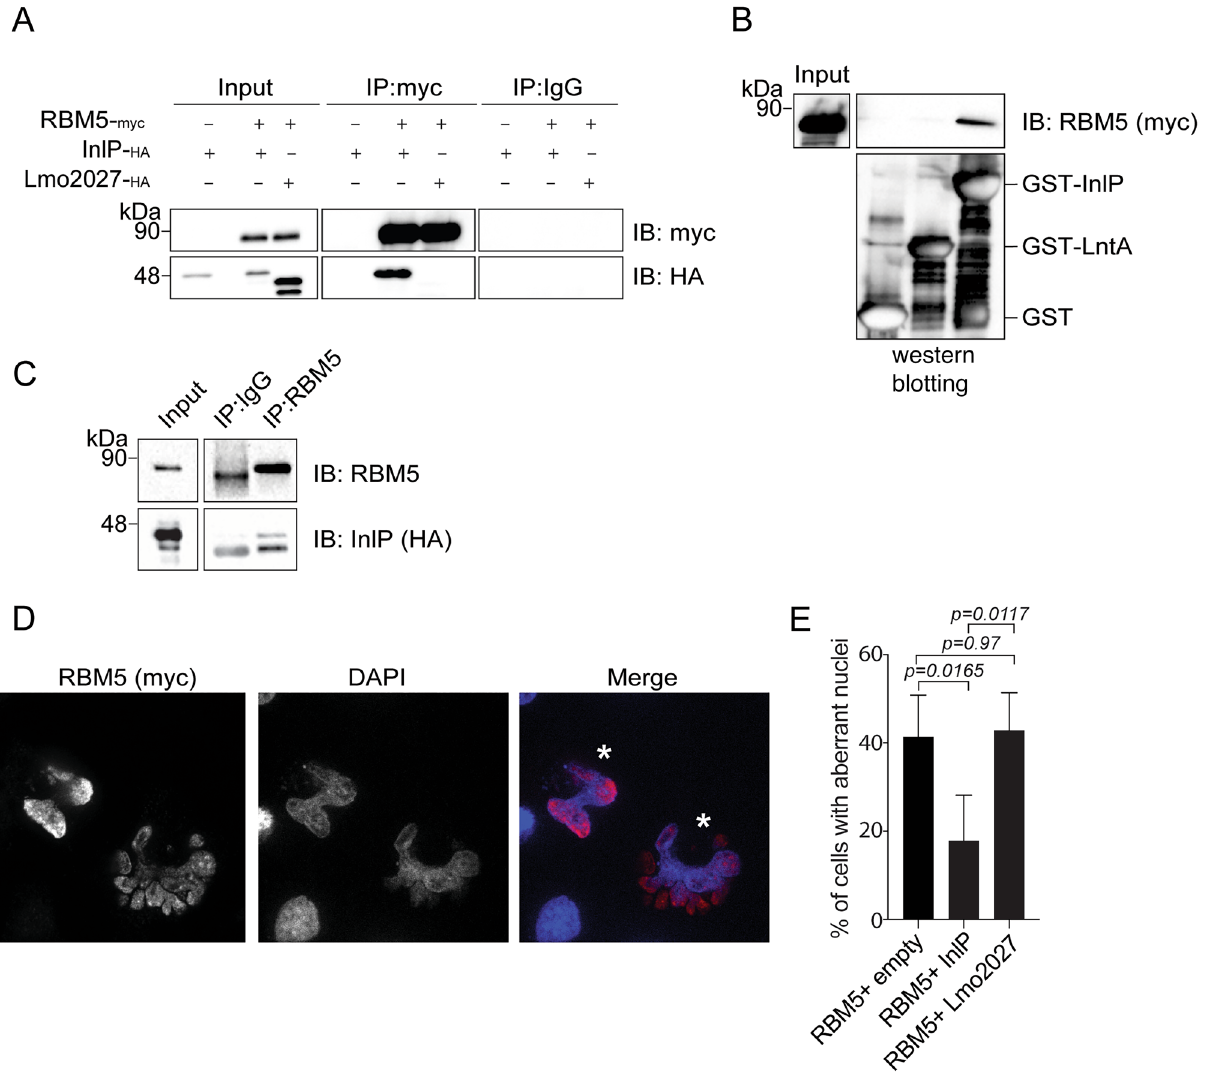
Figure 3. InlP targets RBM5. ( A ) Nuclear extracts from HEK293-FT cells co-expressing RBM5- Myc and InlP- HA or Lmo2027- HA were used in immunoprecipitations (IP) assays with Myc antibodies or IgG control and analyzed by immunoblots with Myc or HA antibodies. ( B ) Nuclear extracts from HEK293-FT cells transfected with RBM5- Myc were incubated with purified GST, GST-LntA, or GST-InlP. Immunoblots of inputs and eluted fractions were probed with antibodies against Myc or GST. A comassie gel staining of the same fractions is shown below. ( C ) Immunoprecipitation of endogenous RBM5 from HeLa cell transfected with InlP- HA . Immunoblots of inputs and eluted fractions were probed with antibodies against endogenous RBM5 and HA. ( D ) Representative image of the altered nuclear morphology of HeLa cells transfected with RBM5- Myc ( asterisks indicate aberrant nuclei). ( E ) Percentage of cells showing aberrant nuclei after transfection of RBM5- Myc or co-transfection of RBM5- Myc and InlP- HA or RBM5- Myc and Lmo2027- HA . Data are mean ± SD from at least three independent biological replicates. Statistical significance determined by (Fig. 5C). Importantly, co-expression of the InlP paralog Lmo2027 with RBM5 had, in contrast, no effect (Fig. 5C). Together, these results reveal that RBM5 can induce the formation of a new type of nuclear bodies, which are granules enclosed by SC35, and that the bacterial factor InlP stimulates both the formation as well the recruitment of RBM5 around these structures. We next investigated whether the interaction between InlP and RBM5 was necessary for InlP to stimulate RBM5 granules, ruling out possible indirect effects. For this purpose, we used the OCRE mutant of RBM5 unable to interact with InlP. When overexpressed in cells, RBM5 ∆OCRE induced the formation of nuclear granules as efficiently as the full length RBM5 protein. However, the co-overexpression of InlP stimulated the formation of nuclear condensate only in RBM5-expressing cells and had a very minor effect in RBM5 ∆OCRE-expressing cells (Fig. S5). These results suggest that the interaction between InlP and RBM5 contribute to the formation of RBM5 condensates.